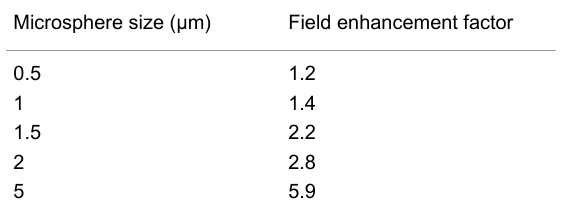
Table 1: Field enhancement by microspheres of different